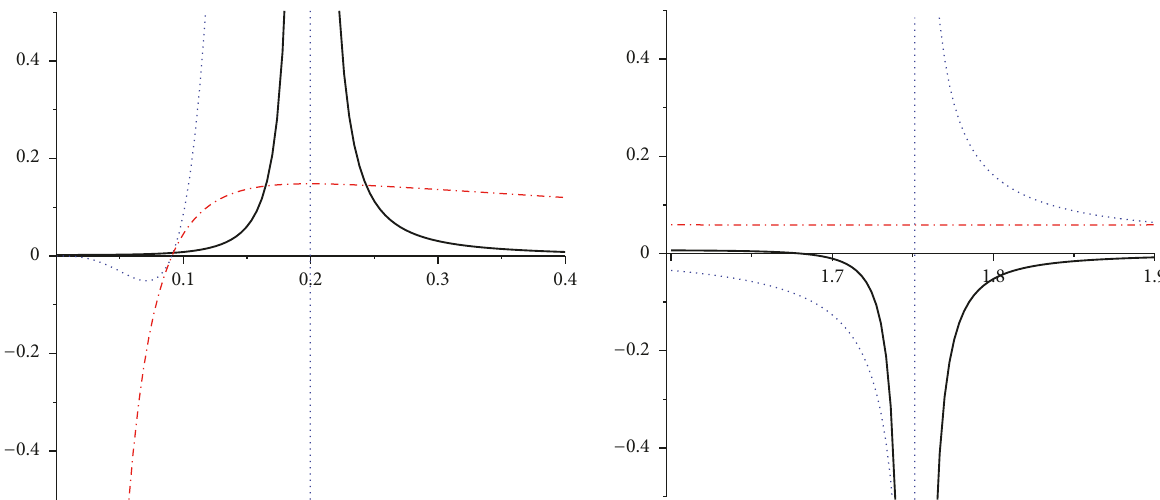
Figure 3: Quevedo metric. R (continuous line), 𝐶 𝑄 (dotted line), and 𝑇 (dot dashed) versus 𝑟 + for Λ = −1 , 𝑛 = 4 , 𝑞 = 0.1 , 𝑏 = 1 , 𝜔 = 10 , and 𝛽 = 1.5 . “Note: both panels are plotted with the same parameters, but different regions.”